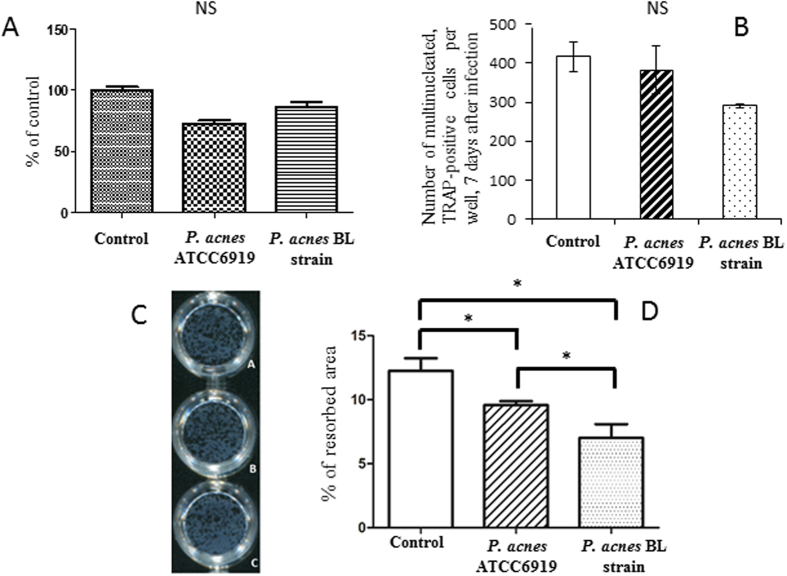
Impact of Cutibacterium acnes on the osteoclast lineage.(A) Cell viability after infection of human CD14+ monocytes by C. acnes. NS: not significant. (B) Effect of infection of human CD14+ monocytes by C. acnes on osteoclastogenesis. Multinucleated cells formed with 3 or more nuclei (osteoclasts) were counted after TRAP staining. NS: not significant. (C) Resorption pit area due to mature osteoclasts uninfected (Ca), infected by C. acnes ATCC6919 (Cb), and infected by C. acnes BL (Cc). (D) Percentage of matrix resorbed by mature osteoclasts uninfected (control), or infected by C. acnes after 48 hours of culture. *P < 0.05 (one-tailed t-test).